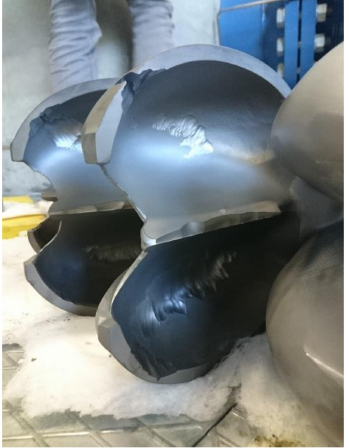
Figure 1. A Pelton turbine with severe sediment